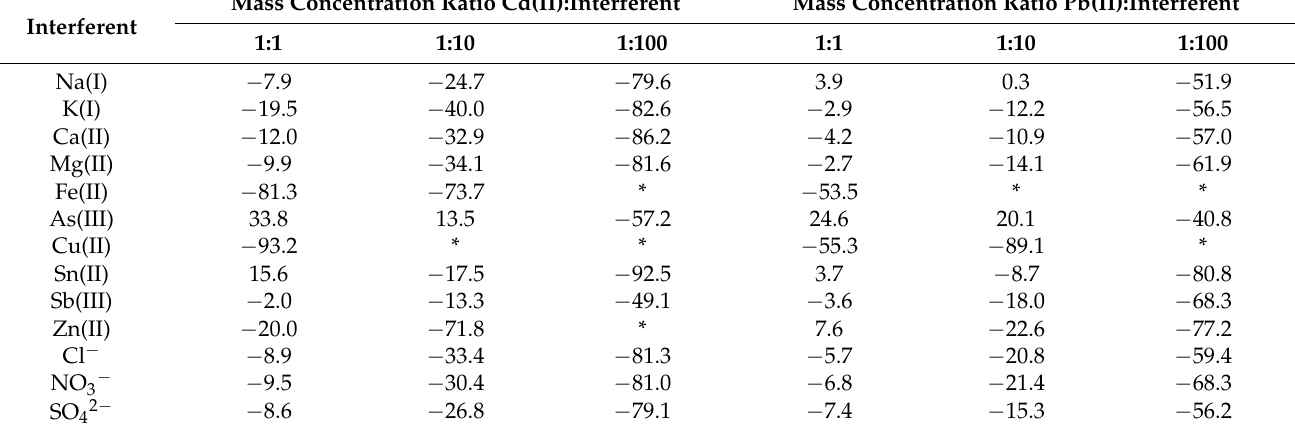
Table 12. The possible interference effect of different species for Cd(II) and Pb(II) determination using Electrode B6 sum